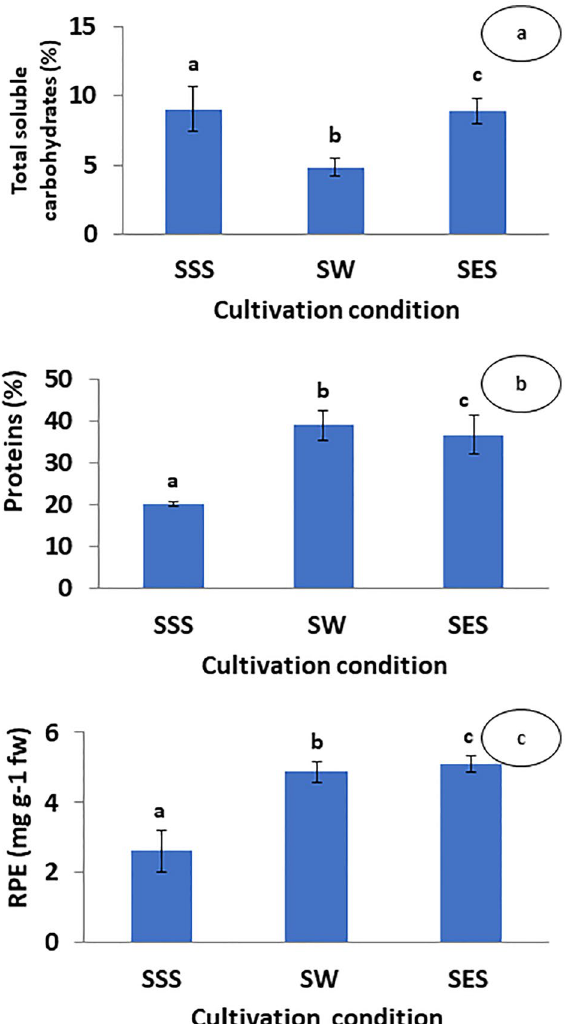
Figure 4. ( a ) Total soluble carbohydrate (%), ( b ) proteins (%) and ( c ) R-phycoerythrin (RPE; mg g −1 fw −1 ) contents of Gracilaria gracilis e xpressed as average ± standard deviation (SD). Sulfur starved seawater (SSS), seawater (SW), and sulfur enriched seawater (SES). Sulfate concentrations [SO 42− ] of the treatments were 2.5 mM, 27 mM and 50 mM for SSS, SW, and SES, respectively; (n =